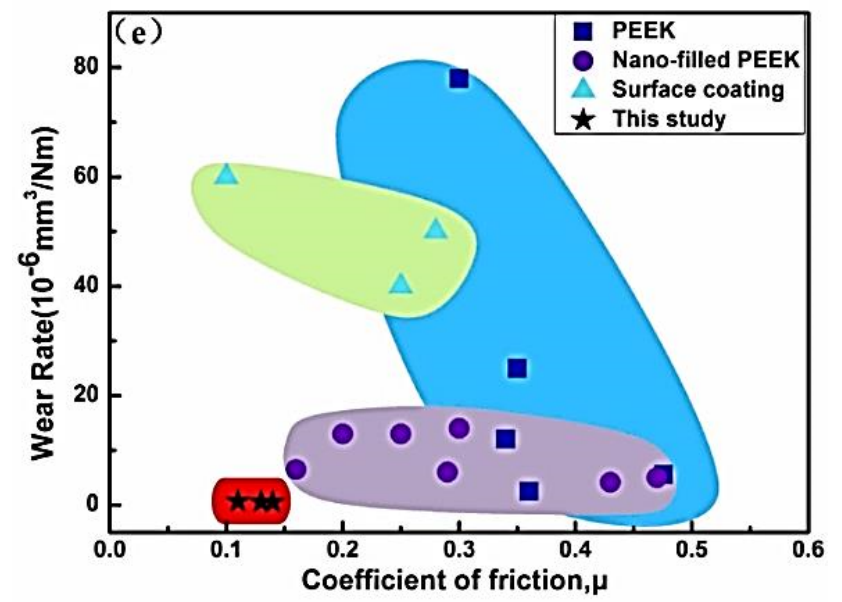
Figure 11. The WR vs. CoF diagram by Ashby (Zhang, 2010; Panin et al., 2021; Yan et al., 2020; Wang et al., 2017; Tharajak et al., 2015, 2017). Figure is reproduced with permission from reference [59].